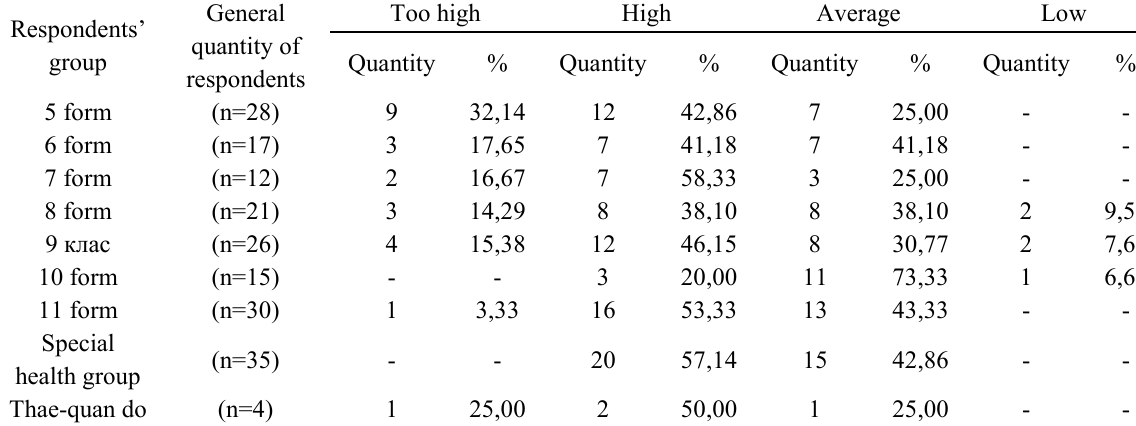
Table 3. General self assessment of physical condition